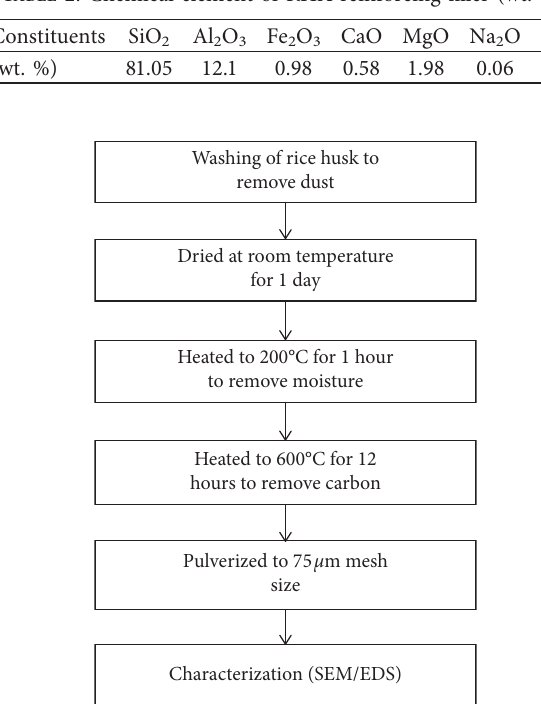
Table 2: Chemical element of RHA reinforcing filler (wt. %).